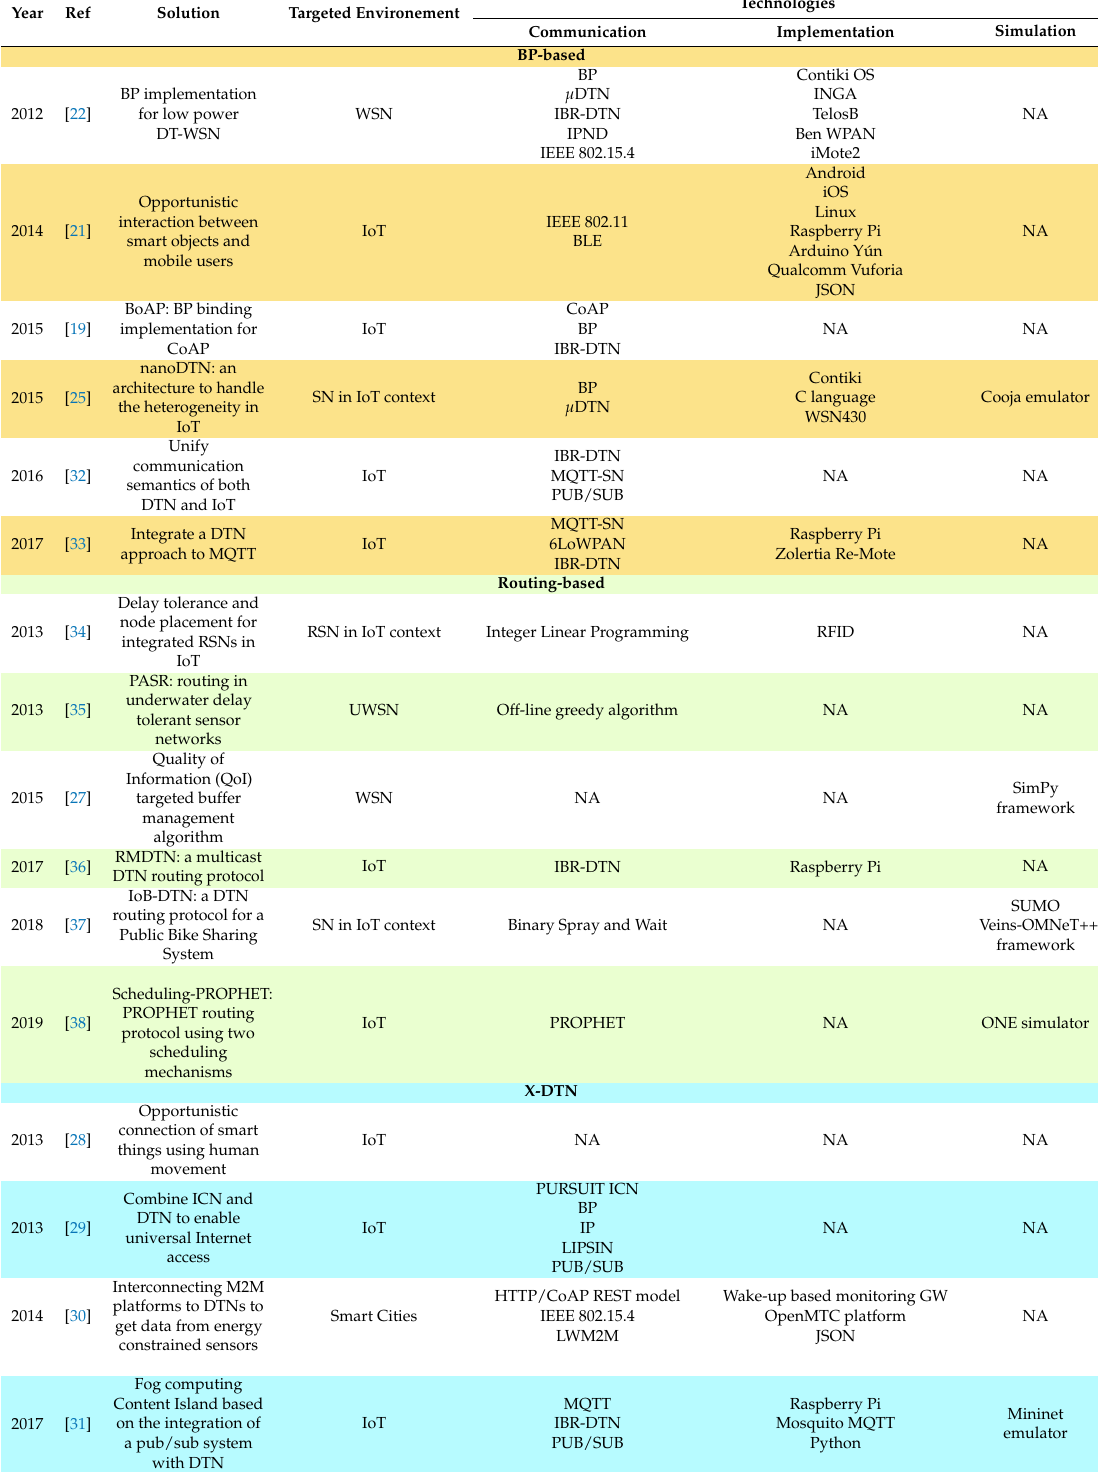
Table 1. Summary and review of different DTN solutions for